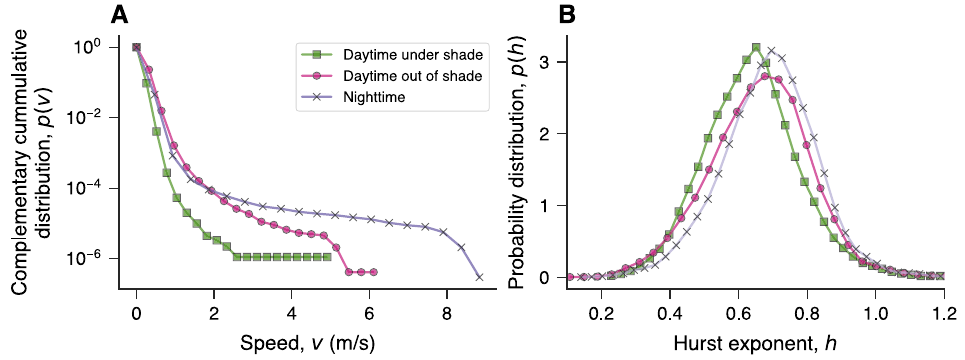
Figure 2. Fish speeds differ during daylight hours in or out of shade structures and at night. ( A ) Complementary cumulative distributions of fish speed v grouped into three categories: daylight hours under shade (green squares), daylight hours out of shade (pink circles), and nighttime positions (purple crosses). Fish move slower under shade structures ( � v � = 0.1286 ± 0.0001 m/s; mean ± standard error of the mean, unless otherwise stated) than out of them ( p -value < 0.001 , permutation test). The average speed is higher when fish are out of shade during daylight hours ( � v � = 0.2324 ± 0.0001 m/s) than at night ( � v � = 0.2086 ± 0.0001 m/s; p -value < 0.001 , permutation test). However, the speed distribution is much more skewed at night [skewness 4.1 ± 0.3 vs. 1.8 ± 0.1 (under shade) and 1.7 ± 0.1 (out of shade); p -values < 0.001 , permutation tests], indicating that fish reach their highest speeds during nighttime. ( B ) Probability distribution of the Hurst exponent h obtained via kernel density estimation from speed time series grouped into the same three categories as the previous panel. Speed time series display long-range persistent behavior in the three categories, but the average Hurst exponent is slightly smaller when fish are under shade during daylight hours ( � h � = 0.639 ± 0.002 ) than when they are out of shade during daytime ( � h � = 0.661 ± 0.002 ; p -value < 0.001 , permutation test) or at night ( � h � = 0.689 ± 0.002 ; p -value < 0.001 , permutation